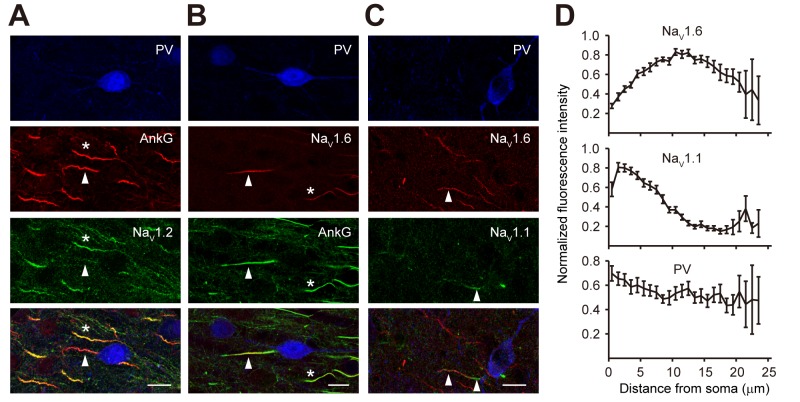
Polarized distribution of NaV1.1 and NaV1.6 at the AIS of PV neurons.(A) Triple staining using antibodies for PV (blue), AnkG (red), and NaV1.2 (green) revealed the absence of NaV1.2 at the AIS of PV neuron (arrowheads). Note that neighboring PV-negative AIS (presumably from PCs, asterisks) show strong immunosignals for NaV1.2. (B) Triple staining for PV, AnkG (green), and NaV1.6 (red). Note that distal regions of AIS were heavily stained for NaV1.6 (arrowheads). Neighboring axons (asterisks) also showed strong immunosignals. (C) Triple staining for PV, NaV1.6, and NaV1.1 shows polarized distribution of these subtypes at the AIS. (D) Plots of the averaged fluorescence intensity (± s.e.m., see Materials and Methods) as a function of distance from soma at the AIS. Data were obtained from triple-staining experiments similar to (C). Images are projections of confocal z stacks. Scale bars represent 10 µm. Error bars represent s.e.m.